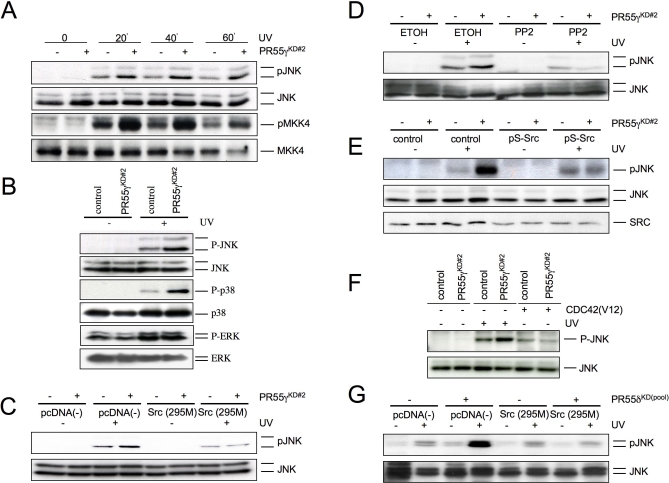
PR55γ Regulates JNK Upstream of MKK4 and at the Level or Upstream of c-SRC(A) pJNK and pMKK4 in relation to the total level of unphosphorylated protein in UV irradiated U2-OS cells followed over time (0–60 min) in the presence or absence of PR55γKD2 vector.(B) U2-OS cells expressing PR55γKD2 or a control vector were treated with UV and incubated for 60 min. Whole cell extracts were probed with the indicated antibodies.(C) PR55γKD2 vector or control vector were cotransfected as indicated in the presence or absence of c-SRC295M (dominant negative). Selected cells were exposed to UV irradiation and whole-cell extracts were analyzed by immunoblotting with antibodies targeting phosphorylated JNK (α-pJNK) or JNK1 and JNK2 (α-JNK).(D) U2-OS cells were cotransfected with PR55γKD2 vector or control vector as indicated and incubated with PP2 for 2 h and UV for 1 h. Whole cell extracts were analyzed by immunoblotting with antibodies targeting phosphorylated JNK (α- pJNK) or JNK1 and JNK2 (α-JNK).(E) PR55γKD2 vector or control vector were cotransfected as indicated in the presence or absence of pSuper-c-SRC. Selected cells were exposed to UV irradiation and whole cell extracts were analyzed by immunoblotting with antibodies targeting phosphorylated JNK (α- pJNK), JNK1 and JNK2 (α-JNK), or SRC(α- SRC).(F) PR55γKD2 vector or control vector were cotransfected as indicated in the presence or absence of CDC42V12 (dominant active). Selected cells were exposed to UV irradiation and whole cell extracts were analyzed by immunoblotting with antibodies targeting phosphorylated JNK (α-pJNK) or JNK1 (α-JNK).(G) Cells were transfected with either the PP2A pool targeting PR55δ vector or control vector and cotransfected as indicated in the presence or absence of c-SRC295M (dominant negative). Selected cells were exposed to UV irradiation and whole cell extracts were analyzed by immunoblotting with antibodies targeting phosphorylated JNK (α-pJNK) or JNK1 and JNK2 (α-JNK).doi:10.1371/journal.pgen.0030218.g004